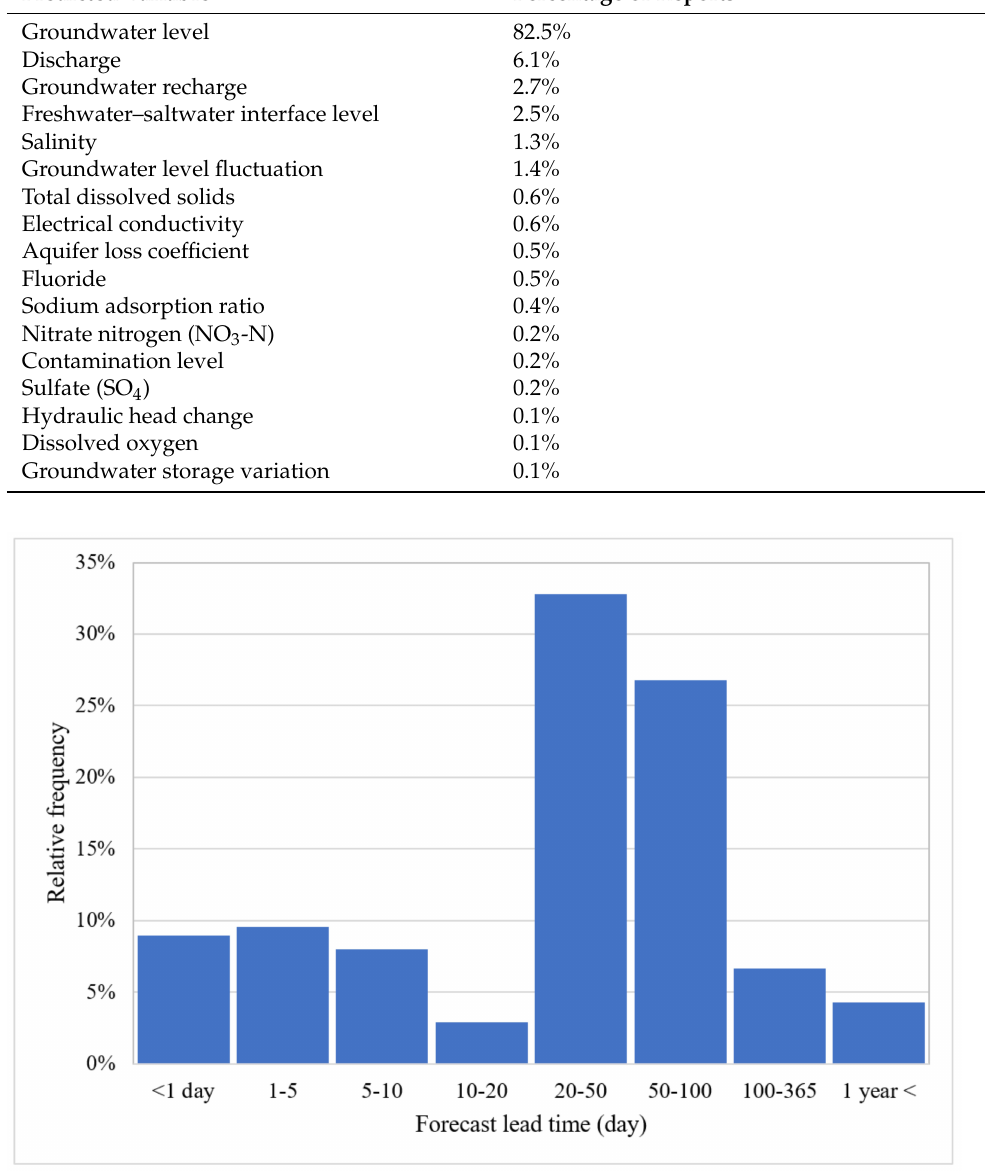
Figure 9. Percentage of reports according to their forecast